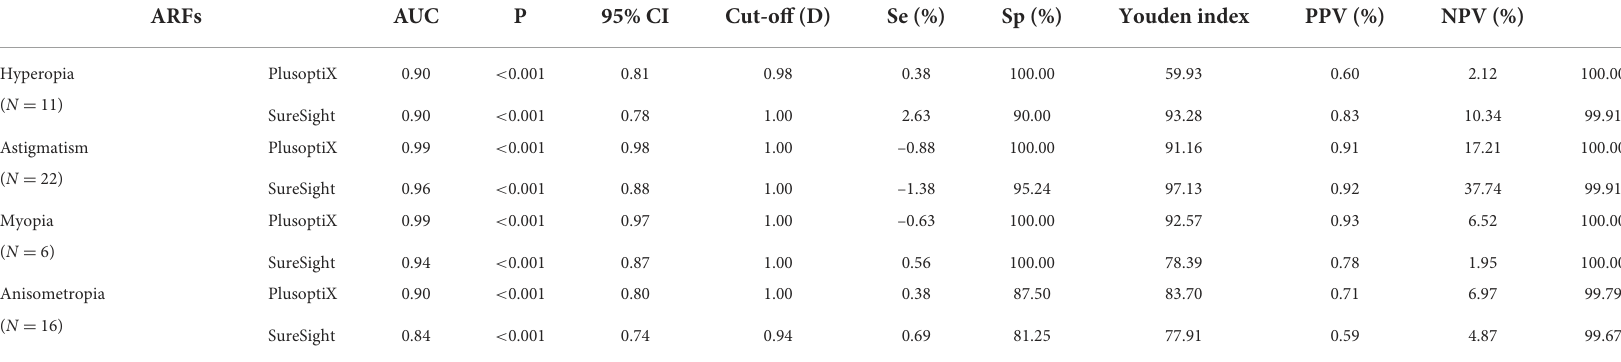
TABLE 3 Characteristics of ROC curves for refractive ARFs obtained by two refractive instrument-based methods compared with cycloplegic retinoscopy.